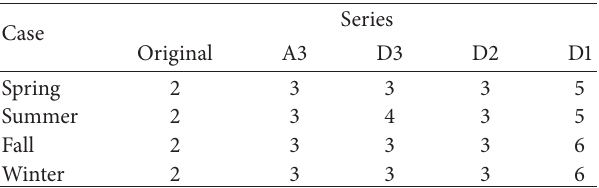
Table 2: Input numbers of neural network models for wind speed